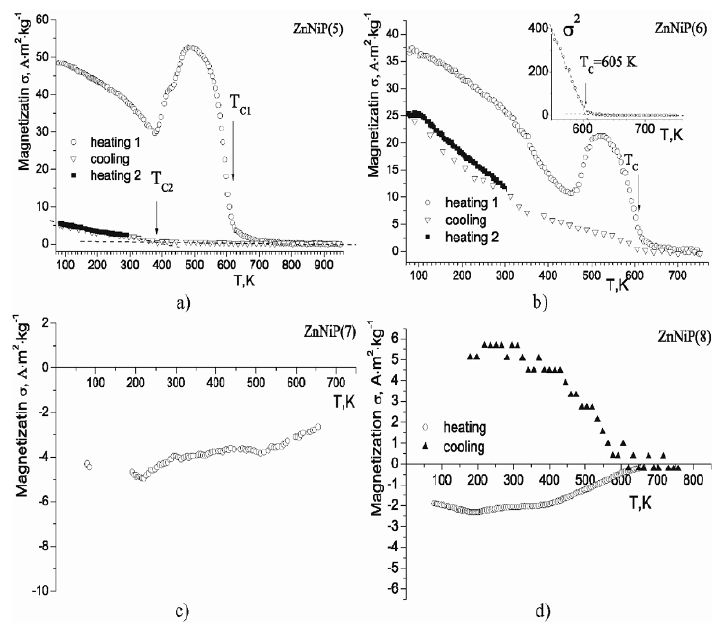
Figure 13. Magnetic measurements for samples: a) ZNP(5); b) ZNP(6); c) ZNP(7); d)